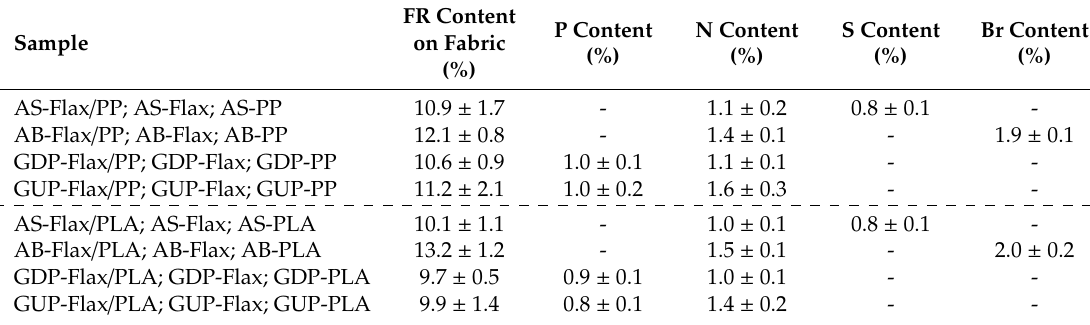
Table 1. Details of flax/polypropylene (PP), flax/polylactic acid (PLA), flax fabrics and PP, PLA fibres treated with different fire-retardant formulations.